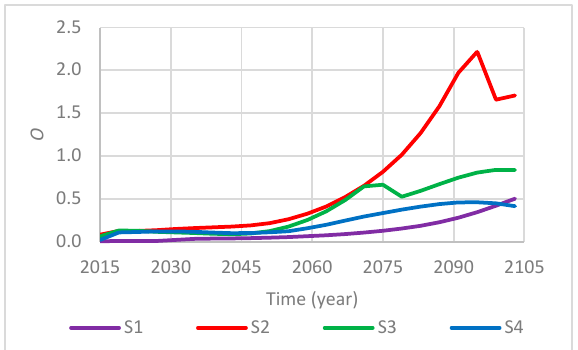
Figure 6. Objective function O (defined as the di ff erence between the relative change in salt export rate and the relative change in catchment discharge rate relative to that in the baseline scenario, Equation (1) for the four di ff erent configurations considered.